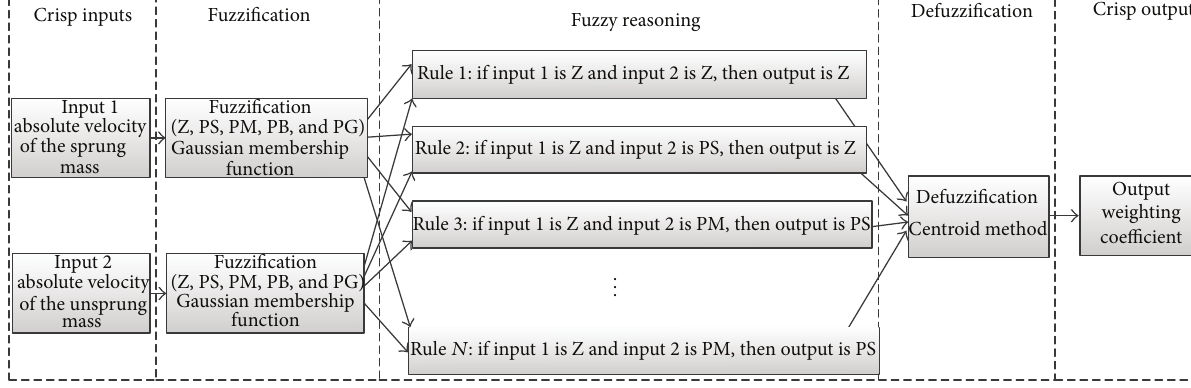
Figure 7: Flowchart of the fuzzy controller.